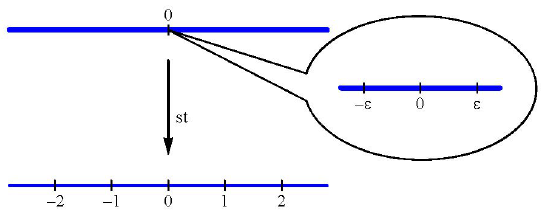
Figure 1: The bottom line represents the “thin” real continuum. The line at top represents the “thick” hyperreal continuum. The “infinitesimal microscope” is used to view an infinitesimal neigh- bourhood of